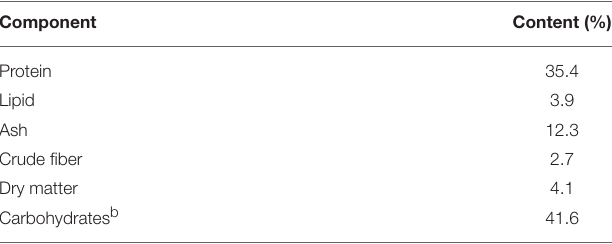
TABLE 1 | Proximate composition of commercial feed applied in this study a .